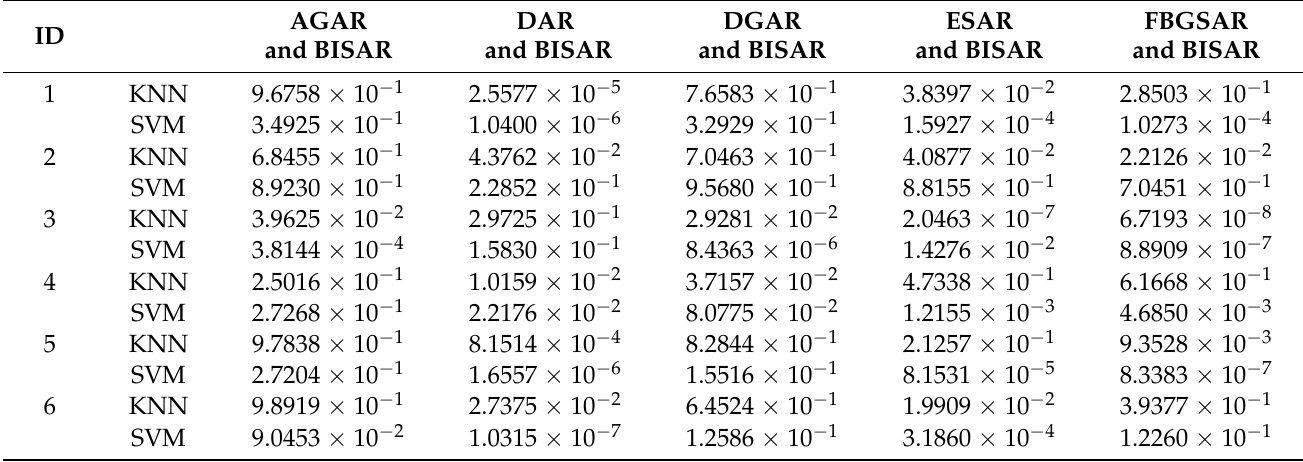
Table 15. p -values for comparing classification accuracies (label